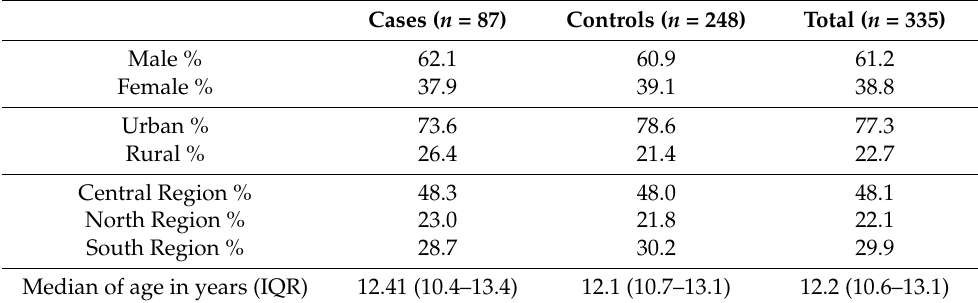
Table 1. Summary of participants’ socio-demographic characteristics.